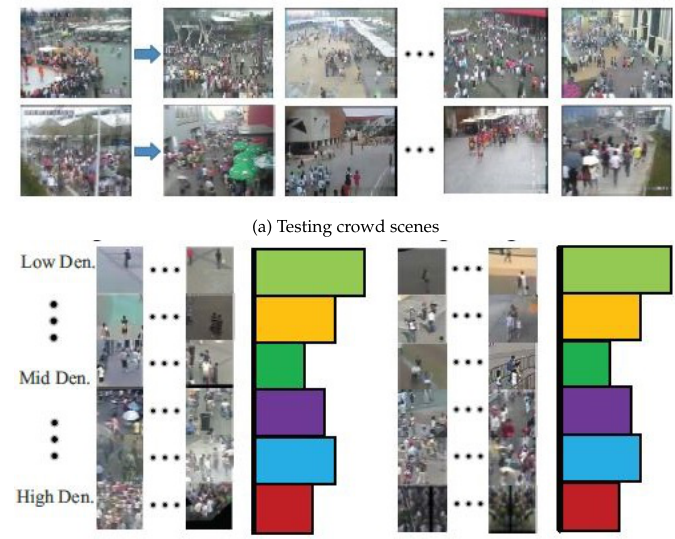
Figure 5. The nonparametric module. Image from